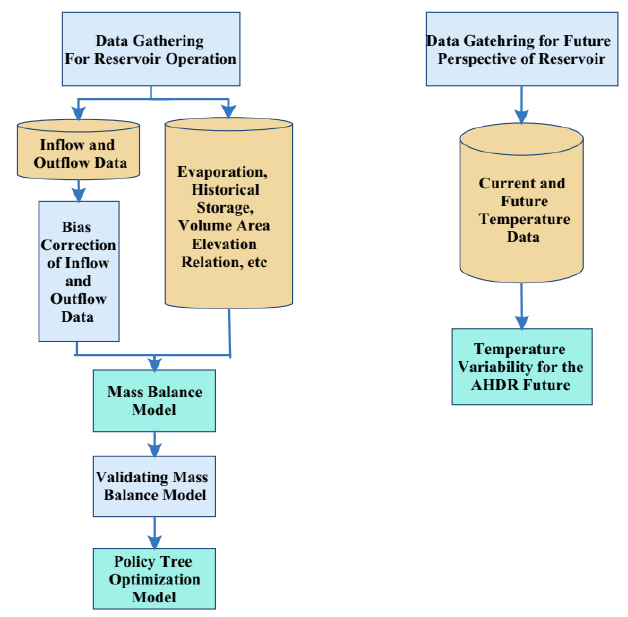
Figure 2. Methodology flowchart .